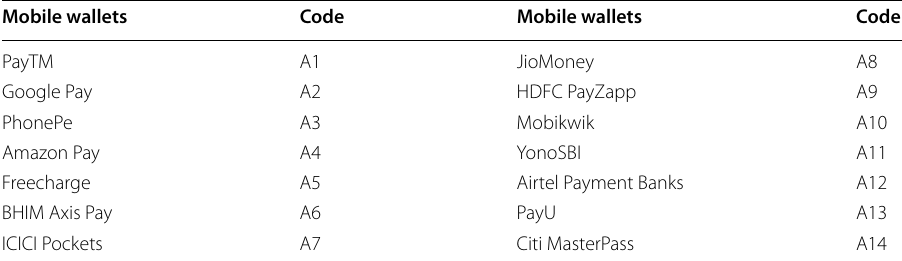
Table 2 List of mobile wallets Mobile wallets